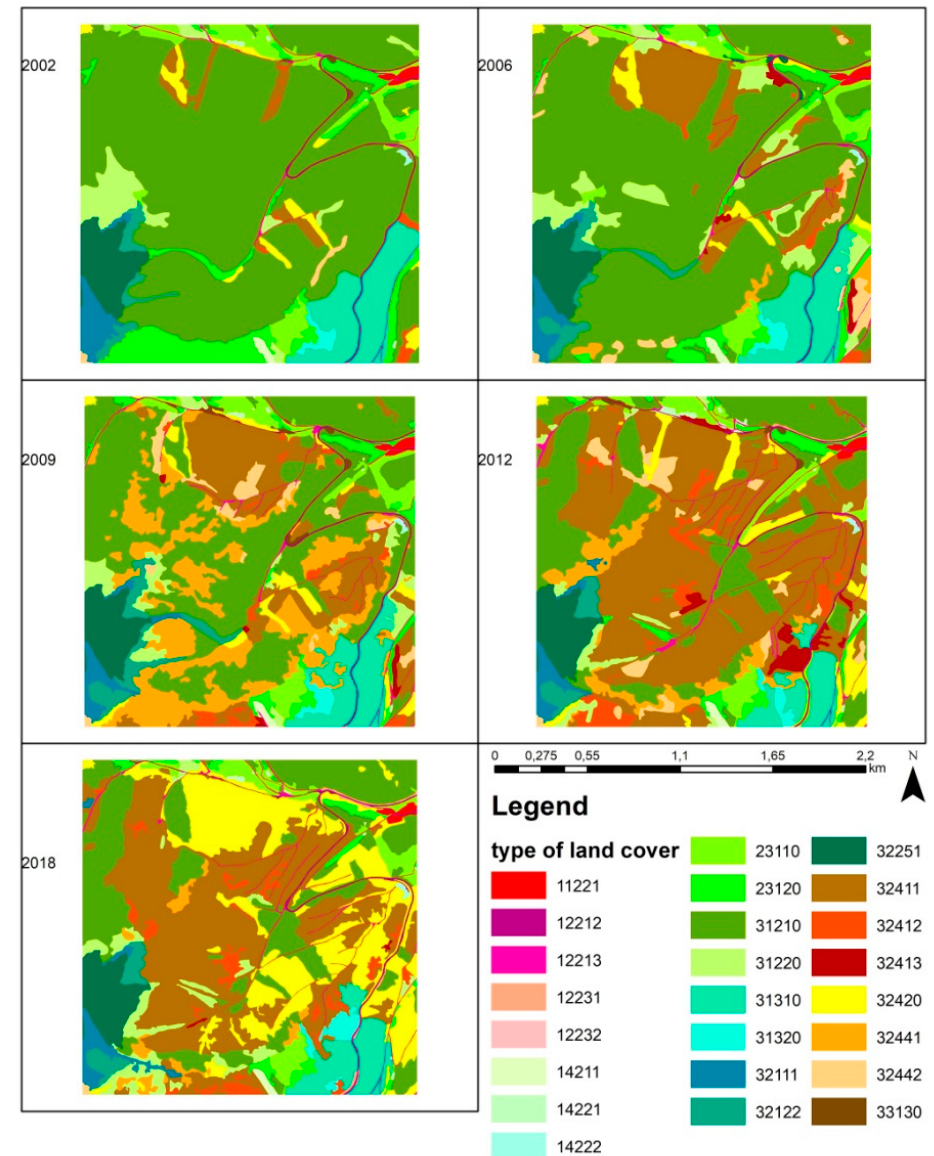
Figure 6. Detailed land cover maps of surroundings of ˇCertovica (NAPALT) in 2002–2018. Descrip- tion of codes: 11221—Discontinuous built-up area with single-family houses, 12212—Roads with a paved surface, 12213—Roads with an unpaved surface, 12231—Accompanying prevailing grass veg- etation, 12232—Accompanying prevailing shrub vegetation, 14211—Areas of sports with prevailing natural surfaces, 14221—Cottage colonies in tree (forest) areas, 14222—Mountain hotels and cottages, 23110—Grass stands prevailingly without trees and shrub, 23120—Grass stands with dispersed trees and shrubs, 31210—Coniferous forests with a continuous canopy, 31220—Coniferous forests with a discontinuous canopy, 31310—Mixed forests with a continuous canopy, 31320—Mixed forests with discontinuous canopy, 32111—Alpine meadows, 32122—Natural grass-herbaceous stands with dispersed woody vegetation, 32251—Prevailingly continuous dwarf pine stands, 32411—Clear-cut sites, 32412—Cut sites with individual trees, 32413—Cut sites with groups of trees, 32420 –Young forests succession, 32441—Forests damaged by biological pests, 32442—Forests damaged by natural disasters (windstorm), 33130—Bare soil, clay and loam.